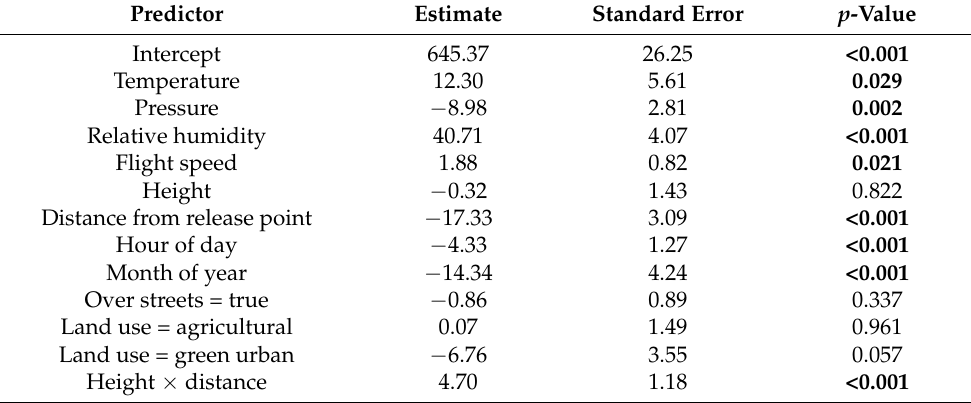
Figure 4. Example of height profile of pigeon track (flight n. 16 in Table A1) with respect to distance from the release point. Colours refer to the CO 2 concentrations measured, which are higher (redder colours) close to the release point in the city centre, and lower (bluer colours) furthest from it. Table 1. Summary of best linear mixed effects model. For each predictor, the coefficient estimate, standard error, and p -value are reported. p -values below 0.05 are reported in